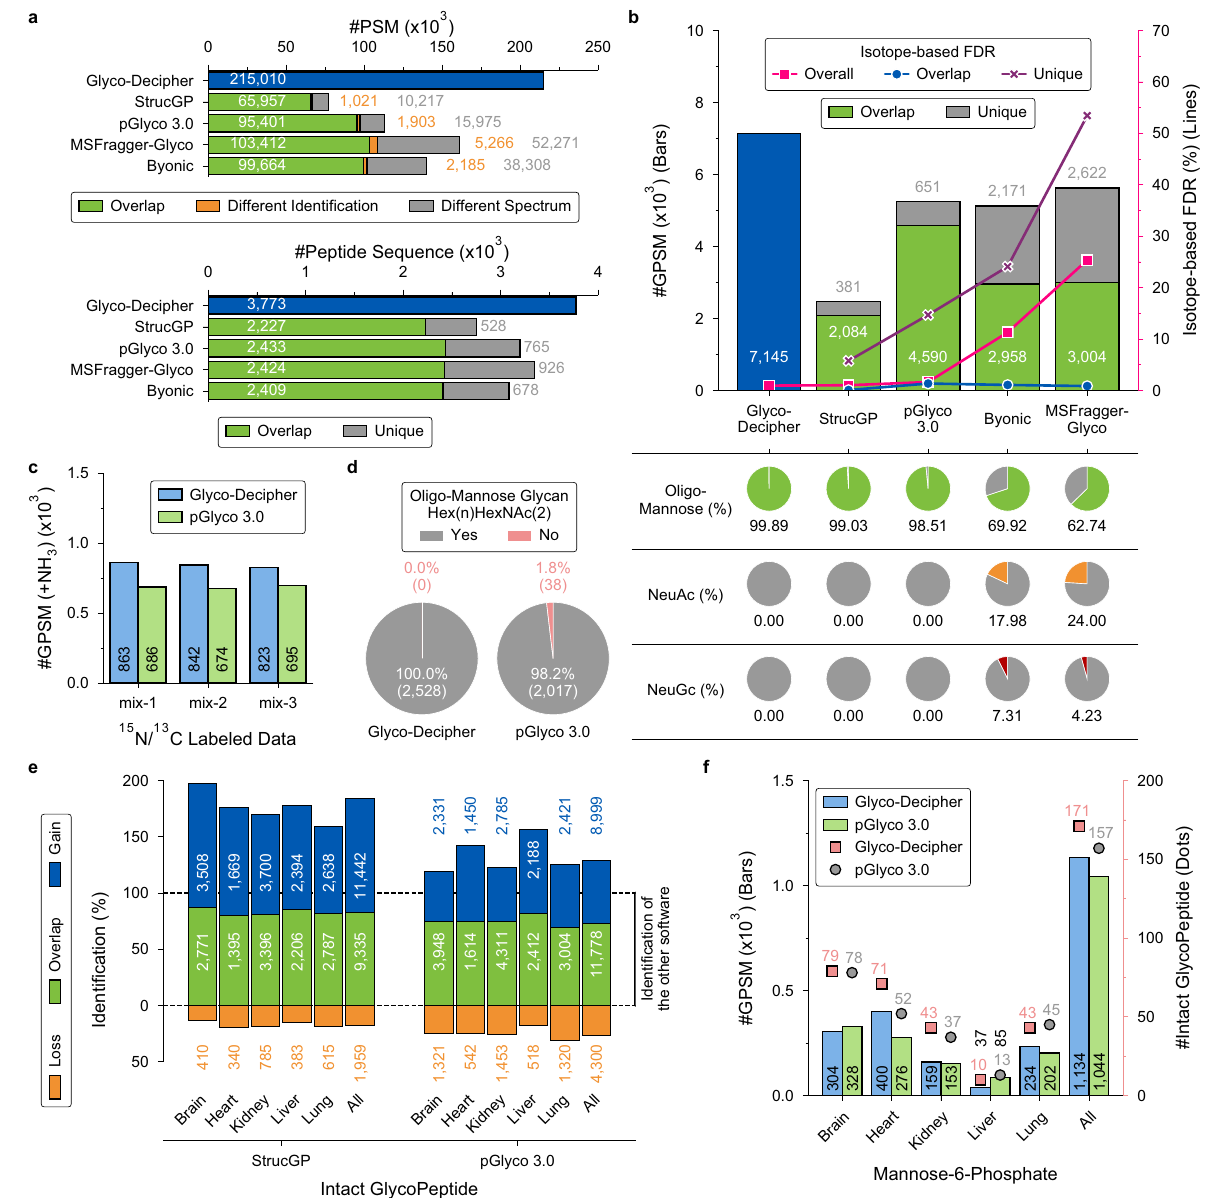
Fig. 4 Comparison between Glyco-Decipher and other software tools. a Comparison of the performance between Glyco-Decipher, StrucGP, pGlyco 3.0, MSFragger-Glyco and Byonic using the dataset of mouse tissues. Top: Comparison between Glyco-Decipher and other software tools in the performance of glycopeptide-spectrum interpretation. Green: the spectra matched to identical peptide backbones in Glyco-Decipher and another tool. Orange: the spectra commonly identi fi ed in Glyco-Decipher and another tool but matched to different peptide backbones. Gray: spectra speci fi cally matched by another tool. Bottom: Comparison between Glyco-Decipher and other software tools in peptide sequence identi fi cation. Green: the peptide sequence commonly identi fi ed by Glyco-Decipher and another tool in pair comparison. Gray: the peptide sequence speci fi cally matched by another tool in pair comparison. b FDR analysis using the 13 C/ 15 N metabolically labeled yeast dataset. The isotope-based FDR was calculated by matching 13 C/ 15 N isotopic peak pairs in MS1 spectra (line). Red line: FDR analysis based on the total GPSM results of each tool; blue line: FDR analysis based on the GPSM results that overlapped with Glyco-Decipher; purple line: FDR analysis based on the GPSMs speci fi cally identi fi ed by each tool. The proportions of GPSMs of oligo-mannose glycans with composition of Hex(n)HexNAc(2) (green pie), NeuAc (orange pie) or NeuGc (red pie) containing glycans identi fi ed by each tool are shown in the bottom table. Source data are provided as a Source Data fi le. c Distributions of GPSMs of ammonium-adducted glycans reported by Glyco-Decipher and pGlyco 3.0. d Number of ammonium adduction GPSMs with/without oligo-mannose glycan composition. e Comparison of glycopeptide identi fi cation results between Glyco-Decipher and StrucGP/pGlyco 3.0. The additional (gain), overlap and lost identi fi cations of Glyco-Decipher compared to other software tools are indicated by blue, green and orange bars, respectively. f Distributions of mannose-6-phosphate (M6P) GPSMs (bars) and intact glycopeptides (dots) across mouse tissues reported by Glyco-Decipher and pGlyco 3.0. All M6P identi fi cations were validated by the diagnostic oxonium ion (phosphorylated hexose, m/z = 243.0269) in the glycopeptide